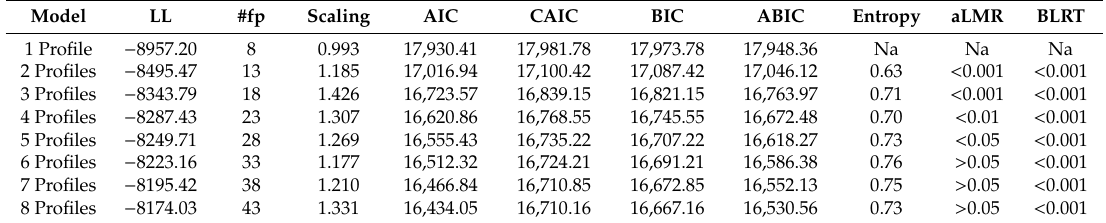
Table 2. Fit indices, entropy, and model comparisons for estimated latent profile analyses